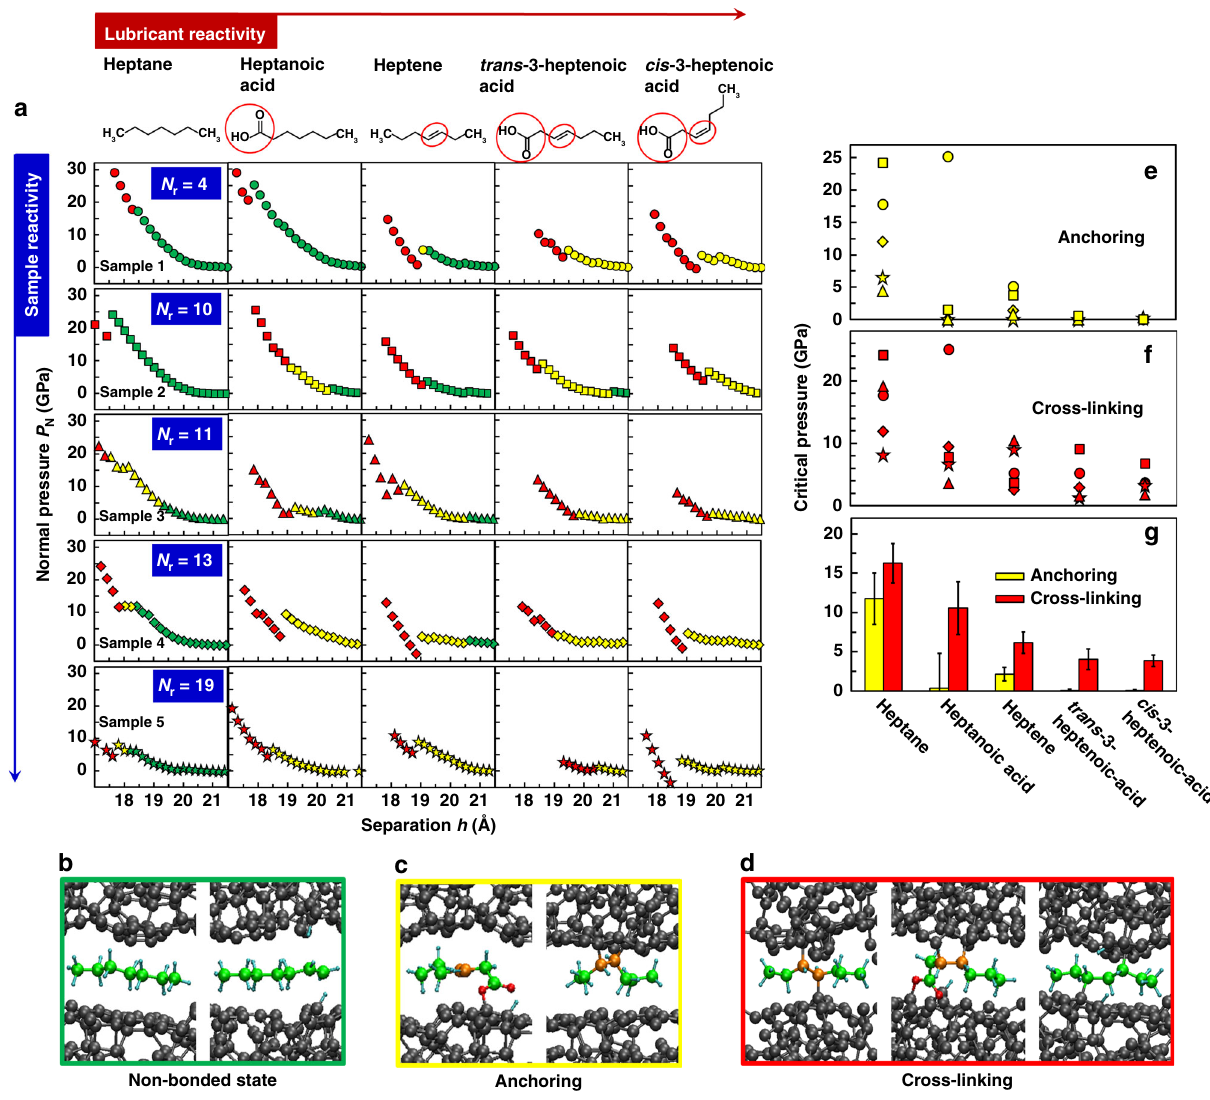
Fig. 2 Quantum-chemical quasi-static pressing simulations of model lubricant molecules con fi ned between ta-C surfaces. a Normal pressure P N as a function of the separation h between two rigid outer C layers for fi ve ta-C samples. The Lewis structures of the model lubricant molecules are shown in the top row. The order of the fi ve ta-C samples corresponds to the number of reactive surface atoms N r (see Methods section). Different symbols are employed for fi ve ta-C samples: circle (sample 1), square (sample 2), triangle (sample 3), diamond (sample 4), and star (sample 5). The colour coding distinguishes interfacial phenomena and structures shown in panels b and c . b , c Representative snapshots for three types of interfacial chemistry: non- bonded state (green, panel b ), anchoring (yellow, panel c ) to one surface, and cross-linking (red, panel d ) of both surfaces. Grey spheres represent carbon atoms from the ta-C. Green and orange spheres depict initially single- and double-bonded C lubricant atoms, respectively. O and H atoms are in red and cyan, respectively. e , f Critical pressures P c N for the anchoring of lubricant molecules on one ta-C surface ( e ) and for the formation of chemical bonds across two ta-C surfaces ( f , cross-linking). Panel g shows means of the critical pressures in panels c and d . Error bars represent standard errors of the means. In all panels, the same colour and symbol coding is